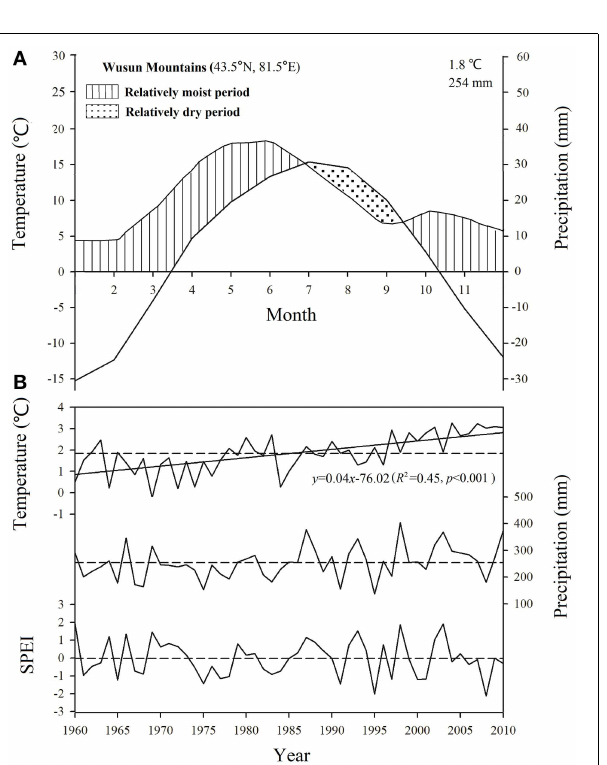
FIGURE 1 | Locations of the study area and of the three sampling sites and the nearest CRU TS location in the Wusun Mountains of northwestern China.